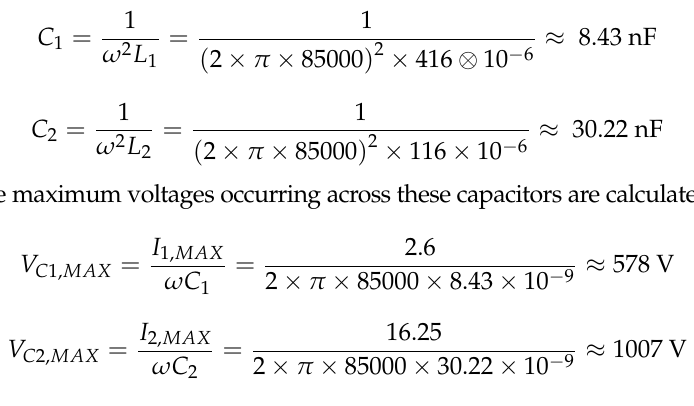
Figure 21. Fabricated coils with ferrite cores: ( a ): Coil1 and ( b ): Coil2.